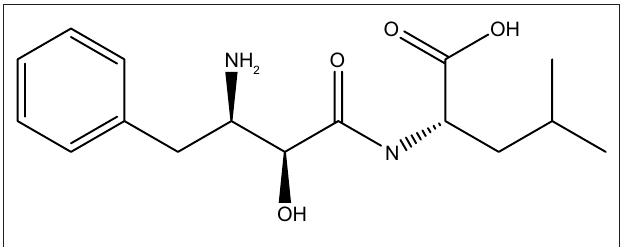
Figure 1 | Bestatin.